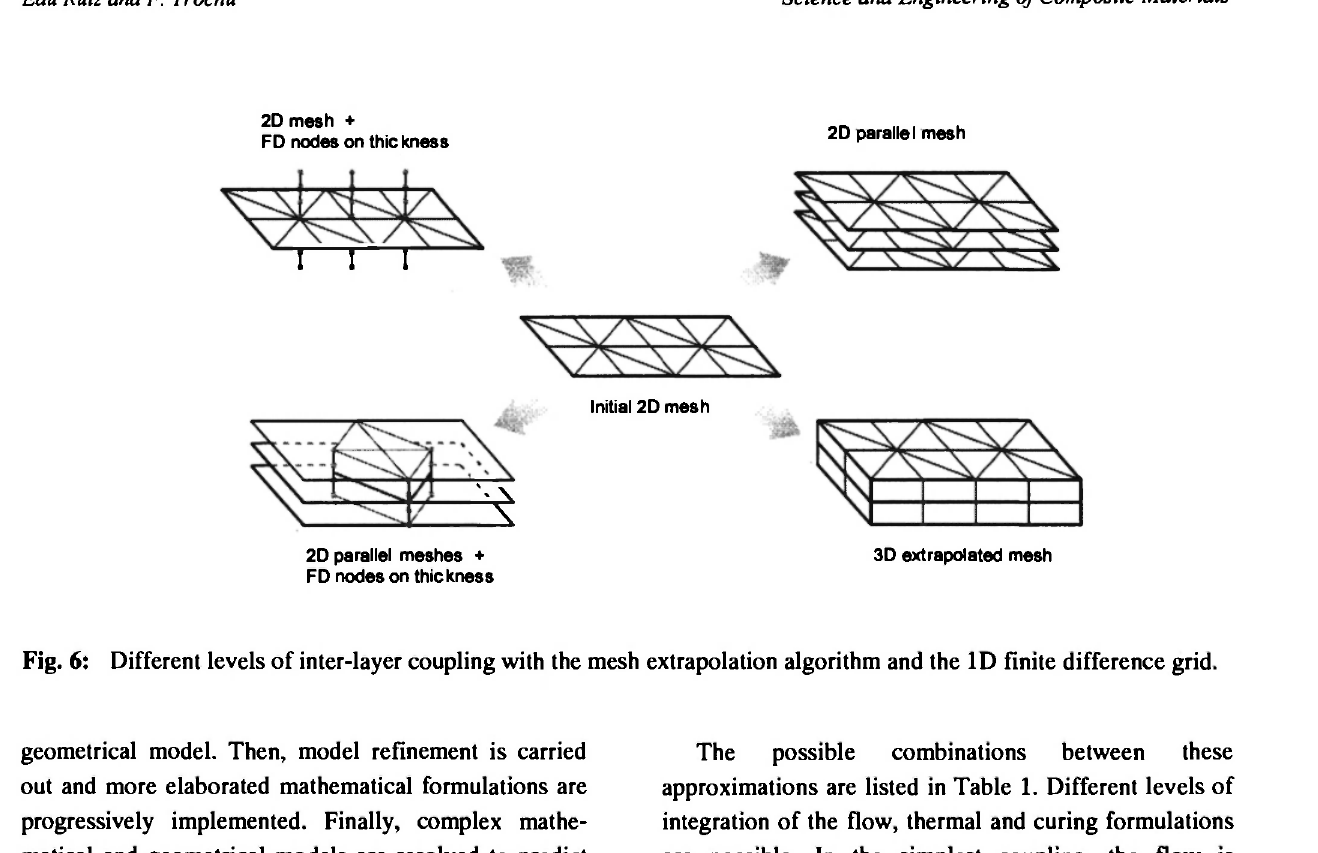
Fig. 6: Different levels of inter-layer coupling with the mesh extrapolation algorithm and the ID finite difference grid.